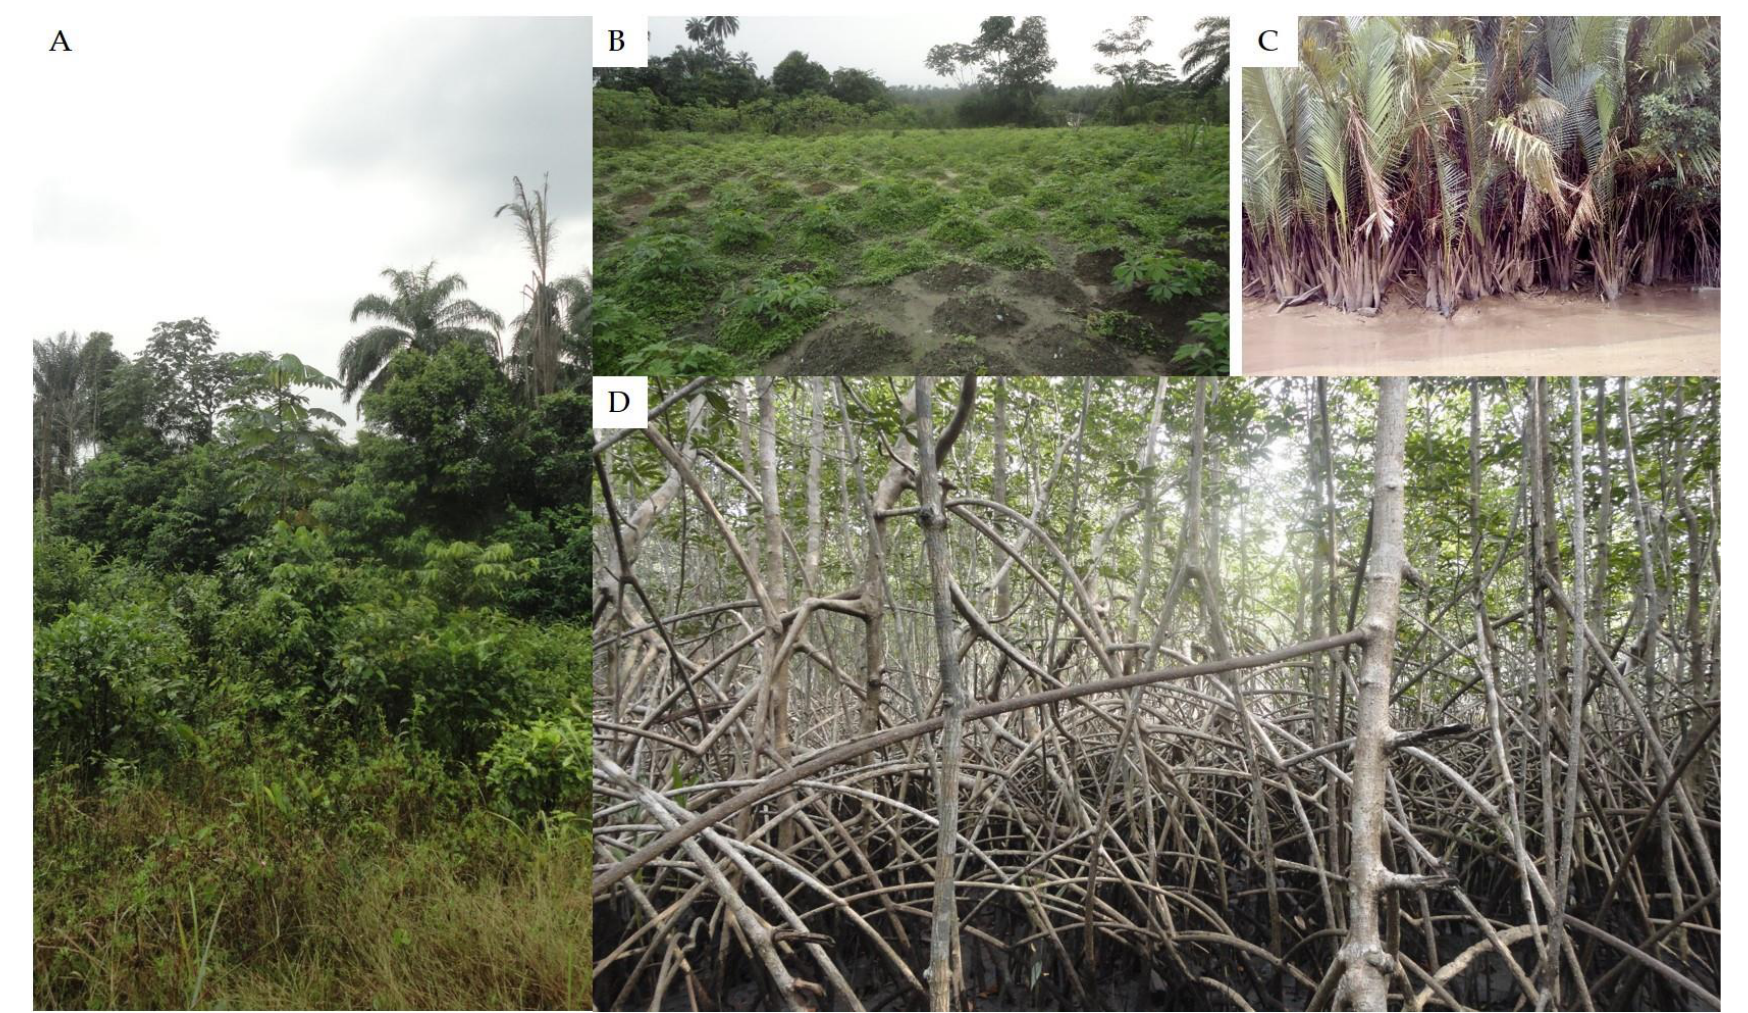
Figure 2 : Land cover classes used in land cover classification. ( A ) Terra firma Forest; ( B ) agricultural land; ( C ) Nipa Palm; ( D ) mangrove forest.